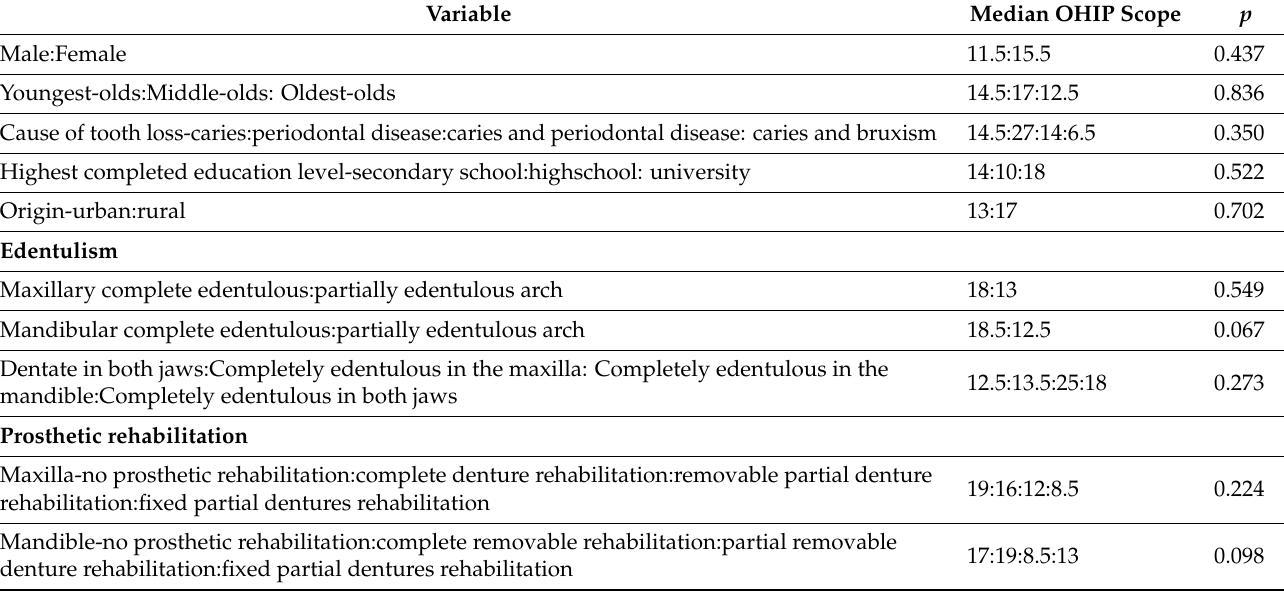
Table 3. OHRQoL related to OHIP-14 scores in the elderly institutionalized